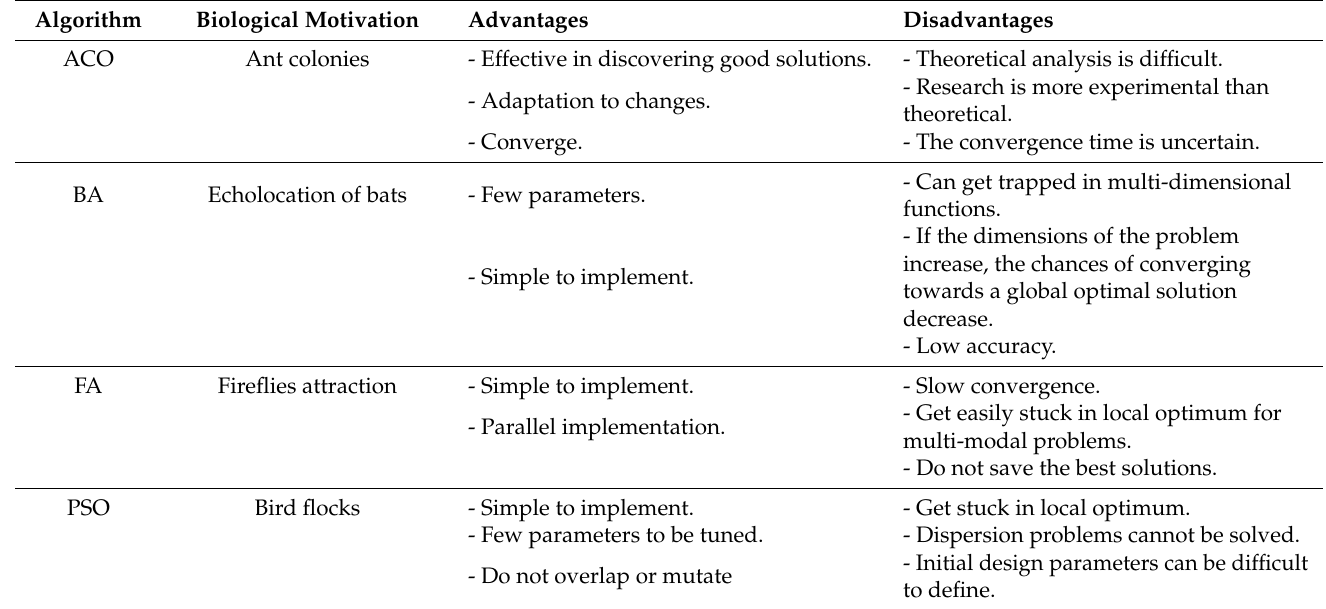
Table 1. Comparison between SI